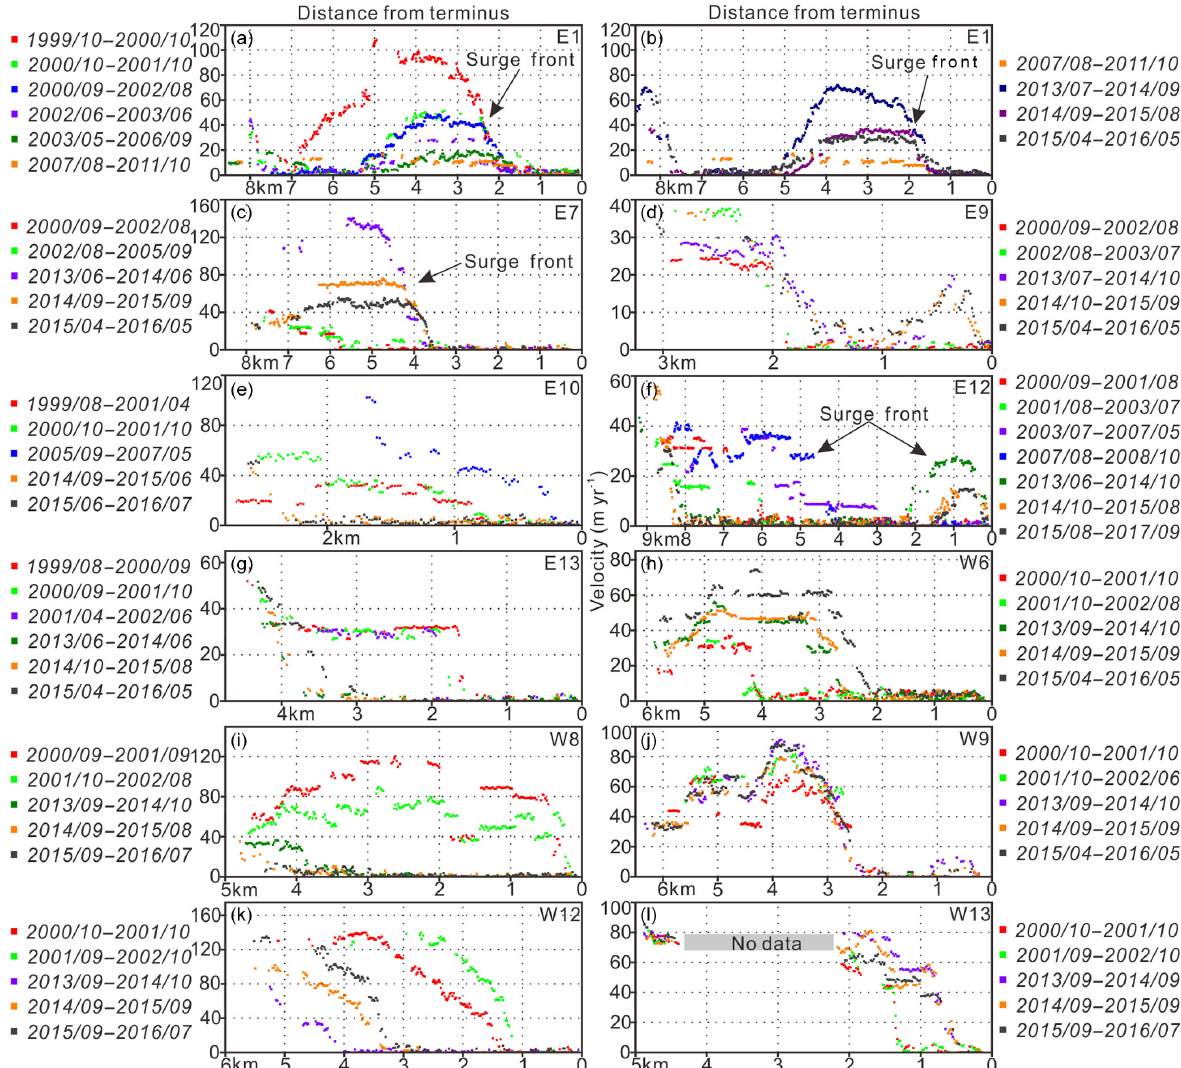
Figure 8. Centre line annual-velocity profiles for surge-type glaciers: (a) E1 (1999–2011), (b) E1 (2007–2016), (c) E7, (d) E9, (e) E10, (f) E12, (g) E13, (h) W6, (i) W8, (j) W9, (k) W12, and (l)